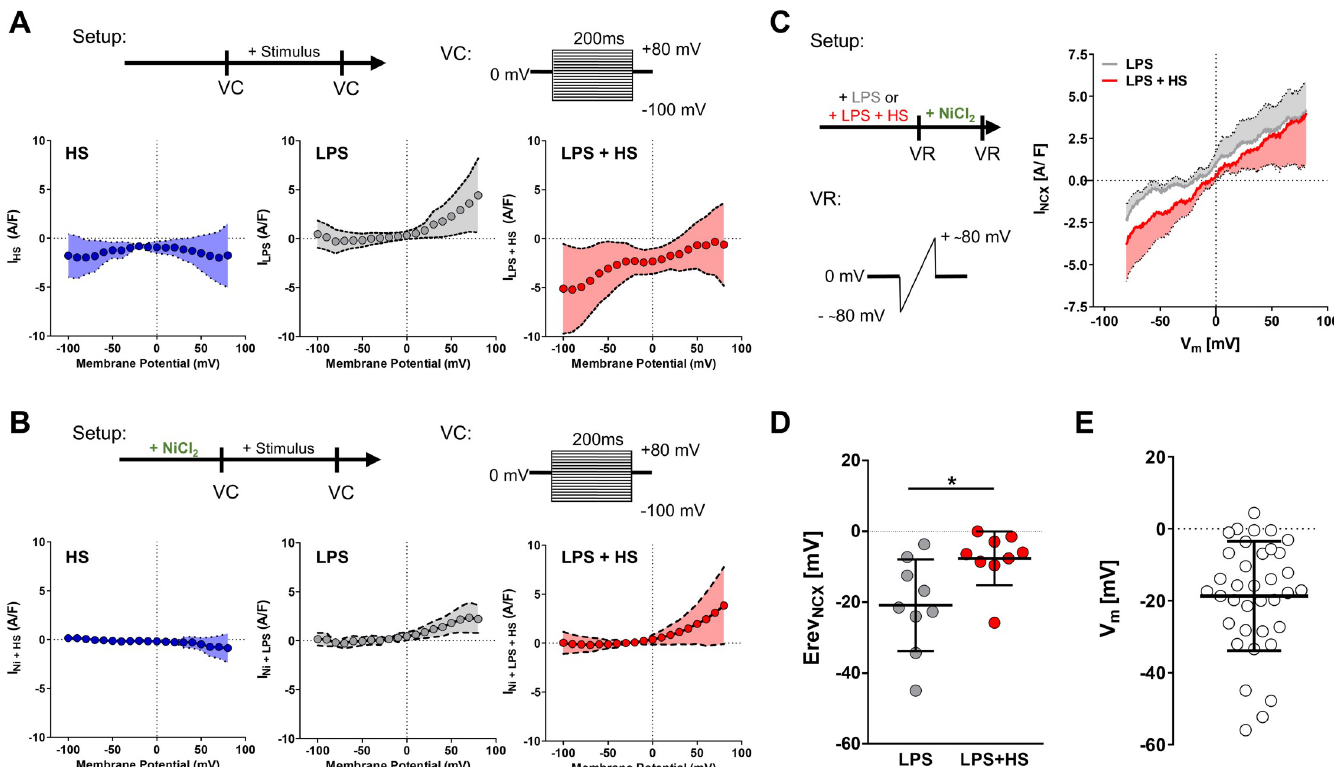
Fig 4. HS exposure results in NCX-mediated inward currents. (A) Current/voltage relationships of M F ± LPS ± HS. Whole-cell VC experiments were performed before and after stimulation of BMDMs. Voltage steps were applied, and differential currents (I HS , I LPS , I LPS+HS ) were plotted (mean ± 95% CI; n = 10–13). (B) As in (A), but with NiCl 2 pretreatment (means ± 95% CI; n = 10). (C) Current/voltage relationships of BMDMs stimulated with LPS ± HS followed by NiCl 2 treatment. Whole-cell VR experiments were performed, and Ni-sensitive (i.e., NCX-sensitive) currents (I NCX ) were determined (means ± 95% CI; n = 9). (D) Erev NCX (means ± SD; n = 9; Mann–Whitney test; � p < 0.05). (E) Resting V m of BMDMs (means ± SD; n = 36). For numerical raw data, please see S1 Data. BMDM, bone marrow–derived M F ; Erev NCX , NCX reversal potential; HS, high salt; I, current; LPS, lipopolysaccharide; M F , monocyte/macrophage-like cell; NCX, Na + /Ca 2+ exchanger; VC, voltage clamp; V m , membrane potential; VR, voltage ramp.